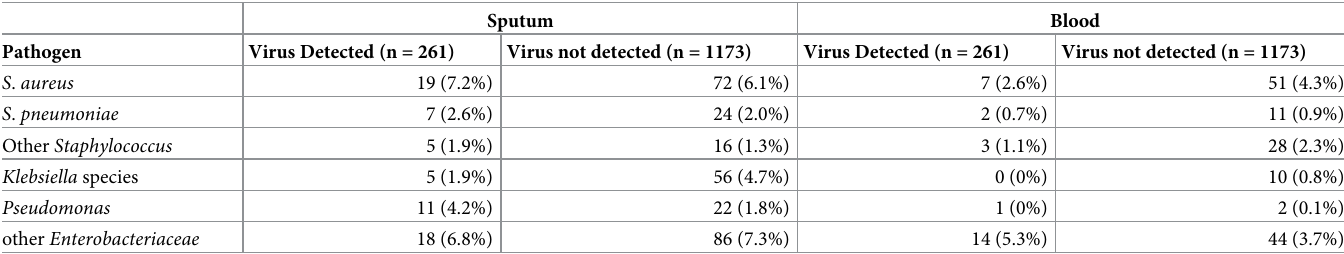
Table 4. Number and percentage of specific bacterial pathogens detected adults with community-acquired pneumonia by sample type and virus